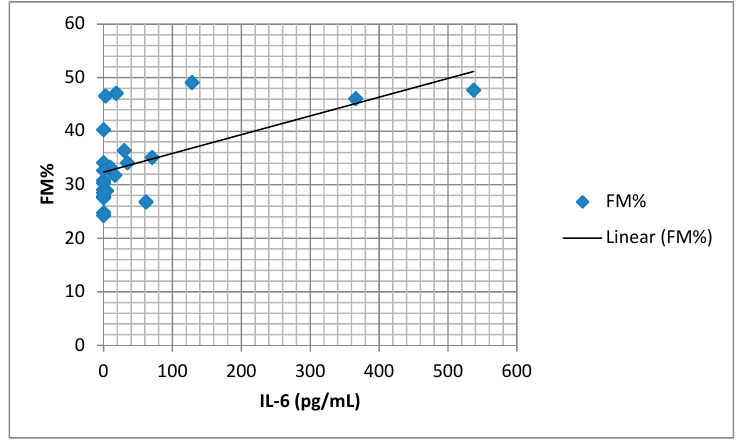
Figure 4. Correlation of serum interleukin-6 (IL-6) and saturation (SatO2) < 90% ( r = 0.437, p = 0.033).